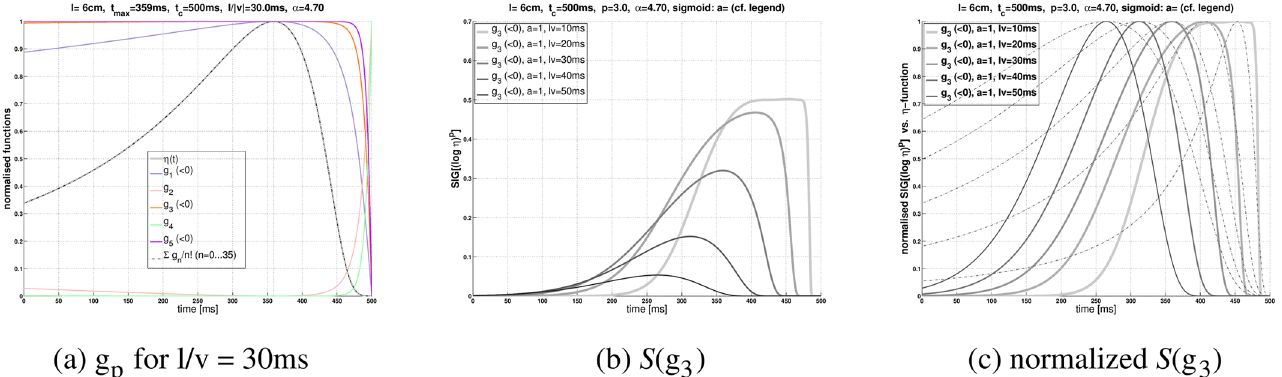
Fig 1. Logarithmic encoding of η ( t ). ( a )The logarithmically encoded η -function log _ Y (cid:4) a Y is “ approximately exponentiated ” by a power law with exponent p according to g p ( t ) = [log η ( t )] p Eq (6). The corresponding curves of g p (with p = 1,2,3,4,5 for l / v = 30ms) are denoted in the legend. For control, the sum P 35 = n ! (exponential series: dash-dotted curve), and the η -function without log-encoding (gray curve) are also shown. Note that the curves become fl atter g p p ¼ 1 with increasing p (and also with increasing l / v — not shown), what could make the detection of the maxima more uncertain in the presence of noise (cf. Fig 2b). ( b )Applying a sigmoidal function S ( x ) = [1 + exp( − ax )] − 1 (with a = 1) to the properly normalized curves g p ( t ) (with p = 3) produces curves which resemble true LGMD responses Eq (8). The curves shown here correspond to different halfsize-to-velocity ratios l / v = 10,20,40,40,50ms (see legend). The peak amplitude of the curves decreases with increasing halfsize-to-velocity ratio, but also with increasing a and p , respectively (not shown). ( c ) Identical with fi gure panel b , but here all curves S ( g 3 ) were re-scaled to the range from 0 to 1. For comparison, the corresponding η -functions are drawn alongside with dashed lines ( α = 4.7, δ = 0, and t c = 0.5s in all fi gure panels).